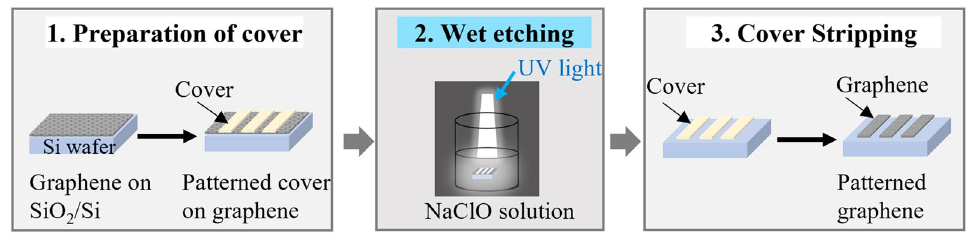
Figure 2. Schematic illustration of wet etching by hypochlorite for graphene patterning.